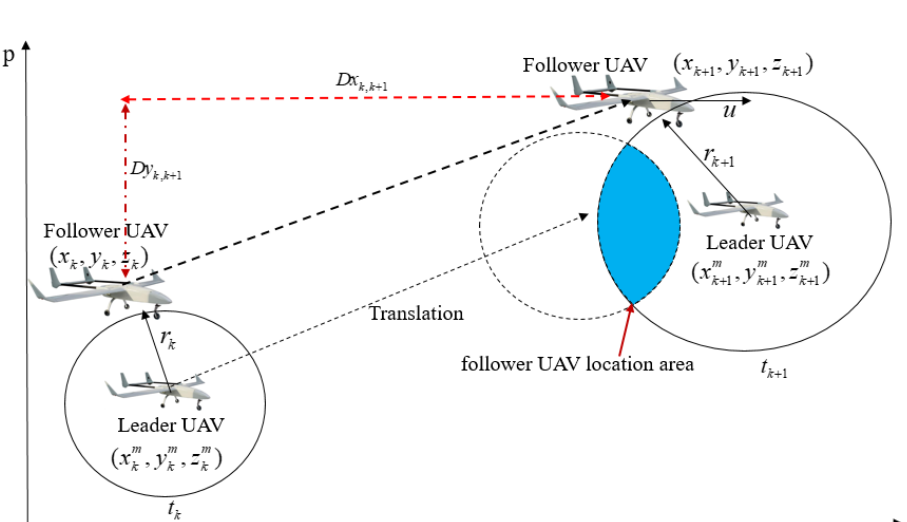
Figure 4. The spatial position relationship in the horizontal direction between leader and follower UAV at adjacent times.